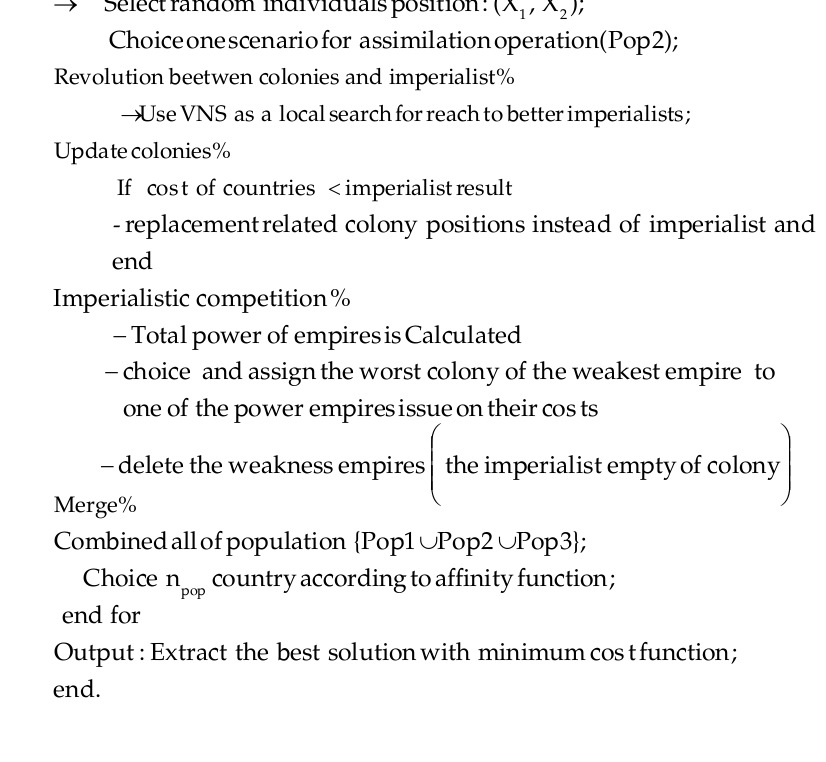
Fig. 7. ICAVNS pseudo